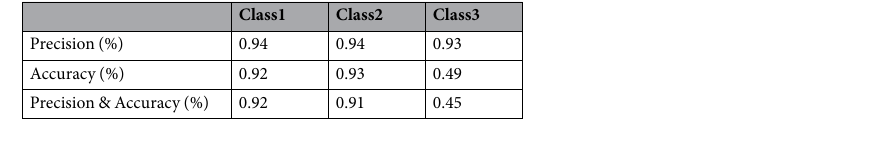
Table 3. Percentage of particles that align with precision, accuracy and both precision and accuracy for an intermediate resolution